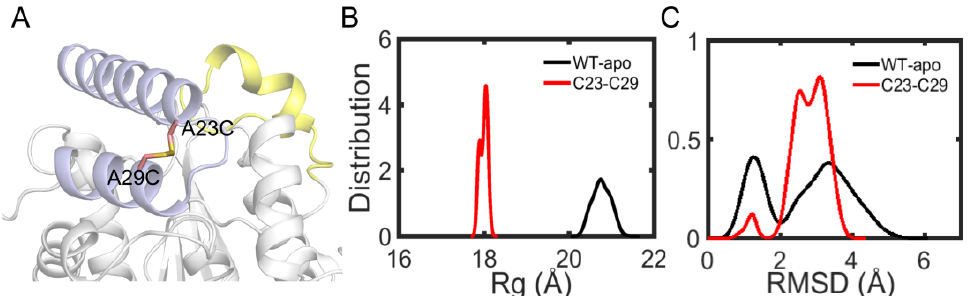
Figure 11. Structure and dynamics information of mutants. ( A ) The mutation sites A23C and A29C are depicted in sticks. ( B ) The distribution plot of R g for the overall structure including wild type and mutant A23C-A29C . ( C ) The RMSD distribution plot of the cap region for wild type and mutant A23C-A29C .